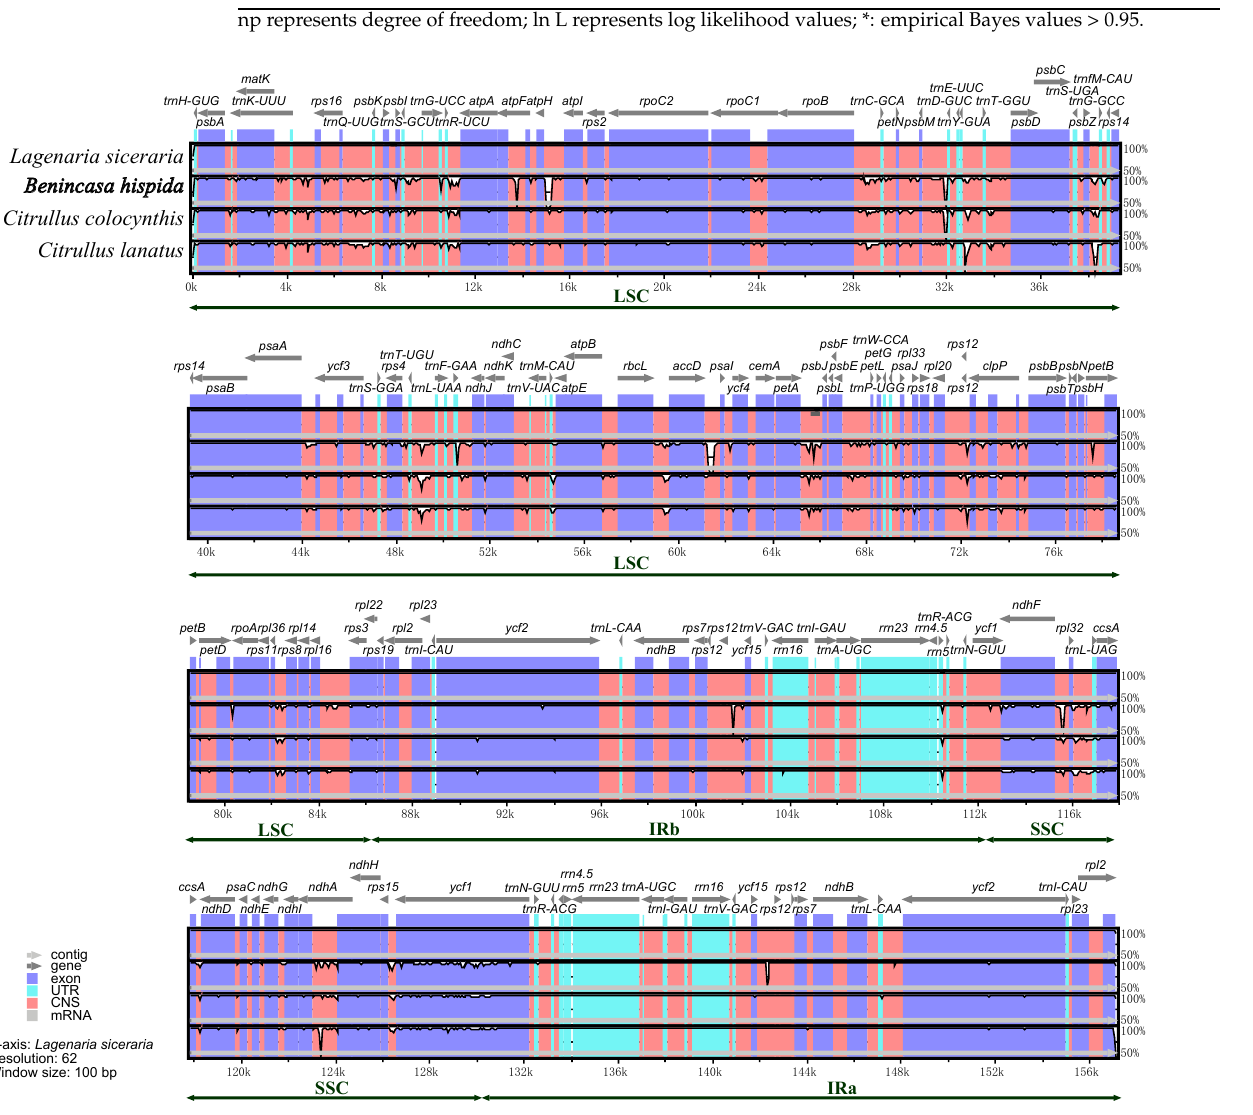
Figure 4. Sequence identity plot comparing the chloroplast genomes among Benincaseae species with Lagenaria siceraria set as a reference using mVISTA. Pink bars represent noncoding sequences (CNS), and white peaks represent genome divergence. The y-axis represents the percentage identity (shown: